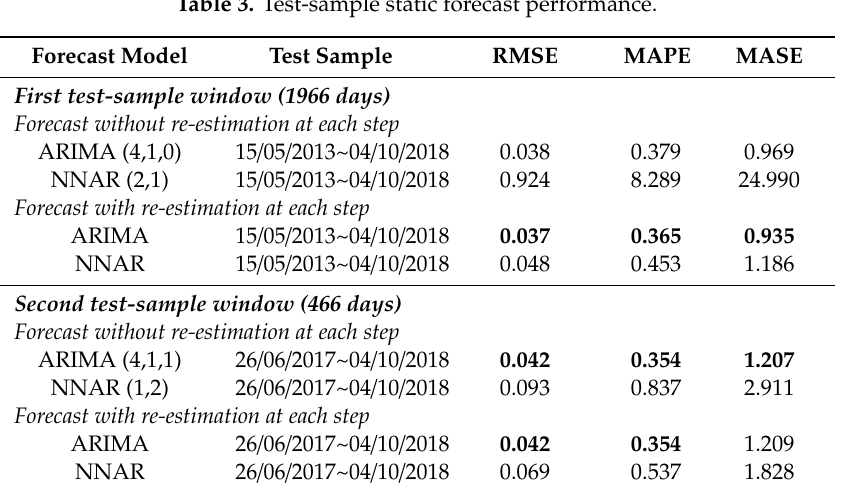
Table 3. Test-sample static forecast performance.